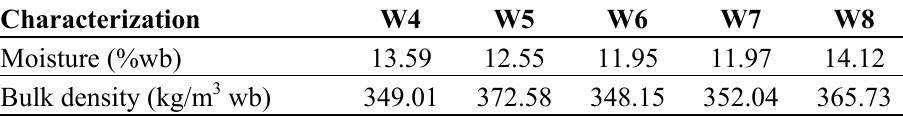
Table 4. Physical characterization of waste